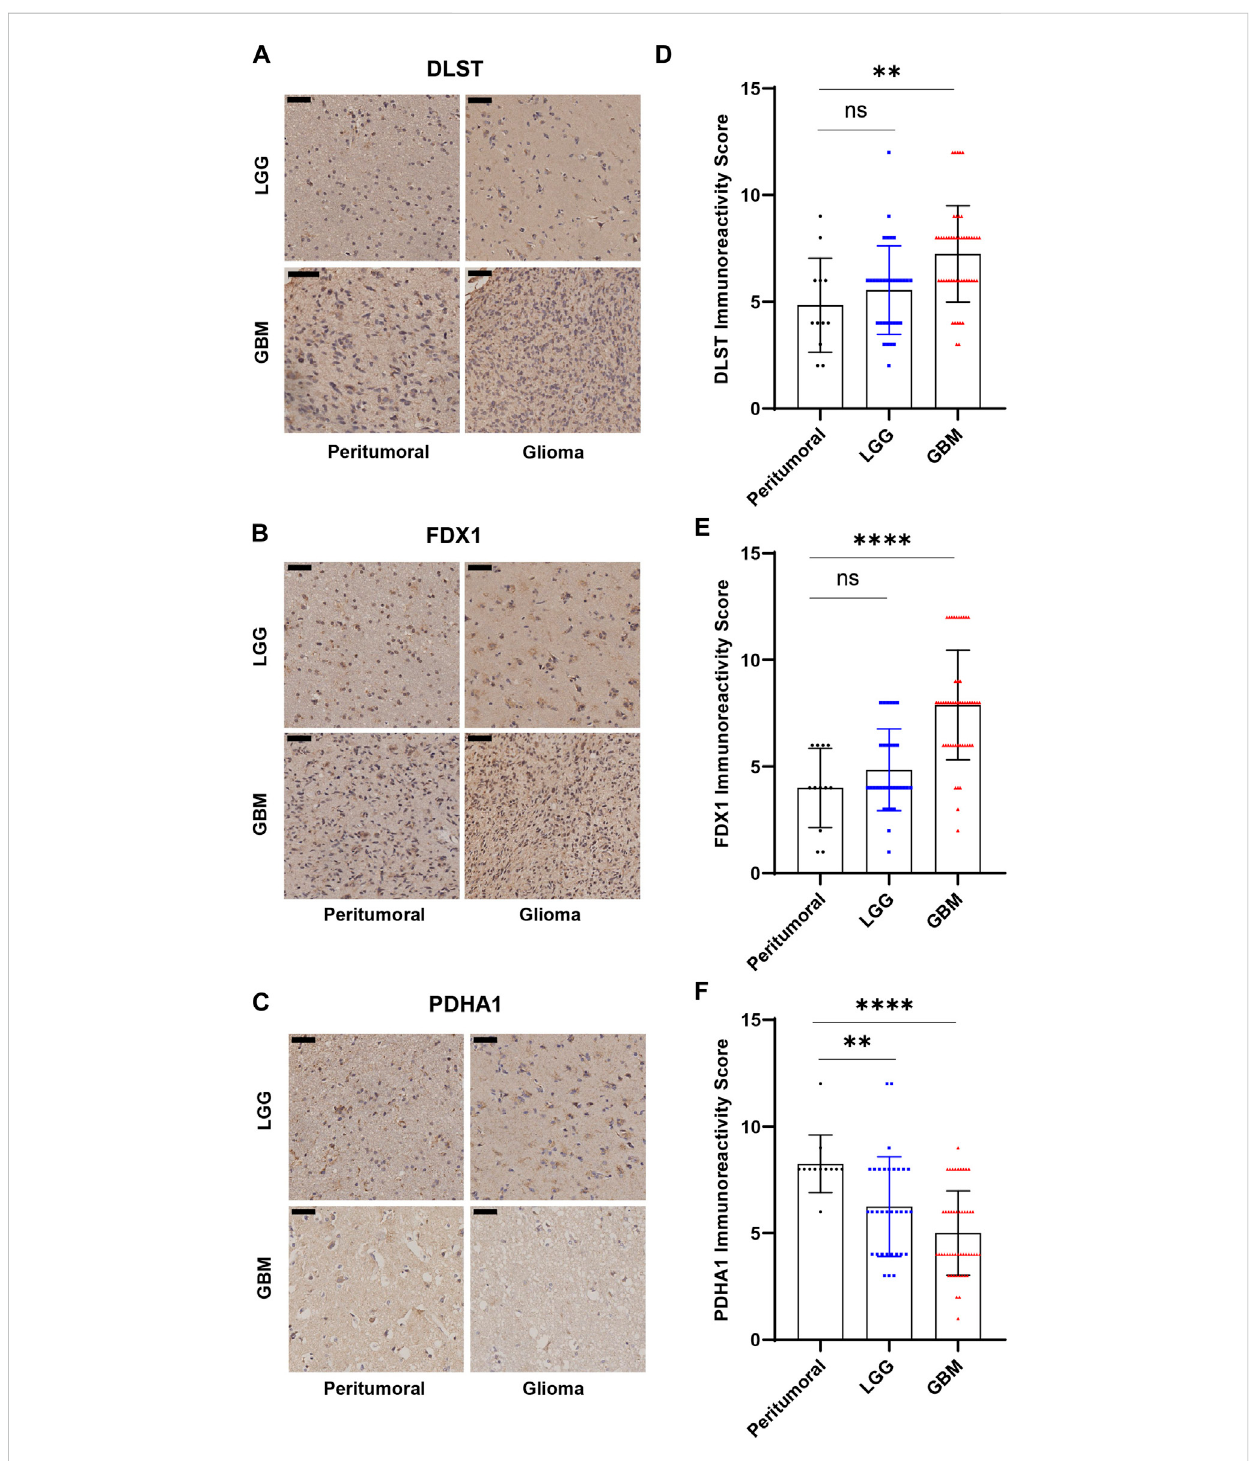
FIGURE 9 Immunohistochemical results of tissue microarrays. (A – C) Immunohistochemistry of DLST, FDX1, PDHA1. (D – F) Statistical analysis of immunohistochemical grades. (* p < 0.05; ** p < 0.01; *** p <